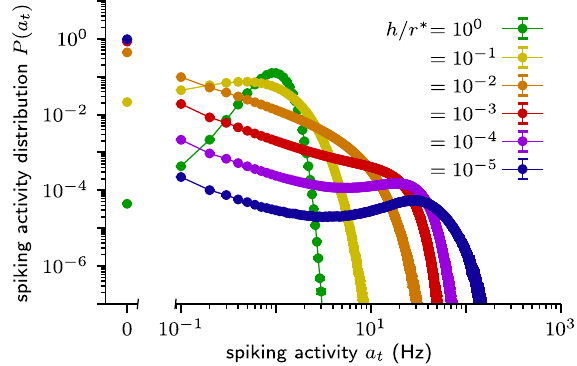
FIG. 5. Distribution of spiking activity in weakly connected 10 − 2 , Δ t ¼ 1 ms, r (cid:2) ¼ 1 Hz, Erd ő s-R´enyi networks ( p con ¼ τ 0 ¼ 10 4 ms) averaged over 12 independent simulations. For irregular dynamics ( h=r (cid:2) ≈ 10 0 ), the distribution is clearly unimodal. For fluctuating dynamics ( 10 − 4 < h=r (cid:2) < 10 0 ), the distribution broadens and shifts the maximum towards quies- cence. In addition, towards the lower bound of the regime, the distribution develops a power-law tail with an exponential cutoff. At the crossover to bursting dynamics ( h=r (cid:2) ≈ 10 − 4 ) the distri- bution becomes